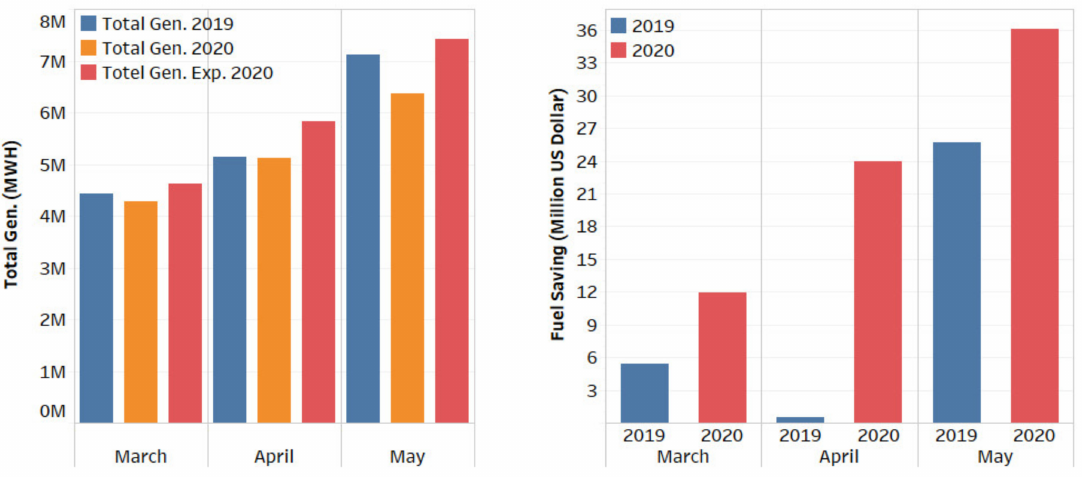
Figure 9. Monthly fuel-saving in US$ million over the pandemic period compared to actual expenditure in 2019 and projected expenditure for